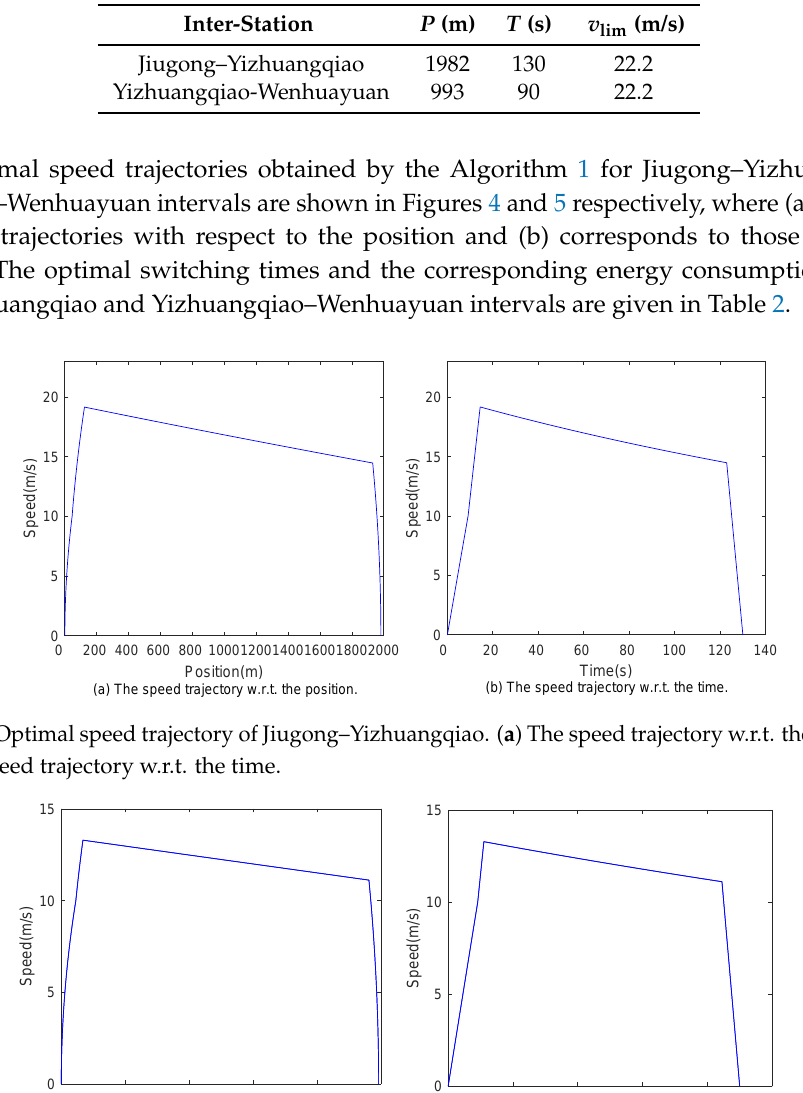
Table 1. The line parameters.